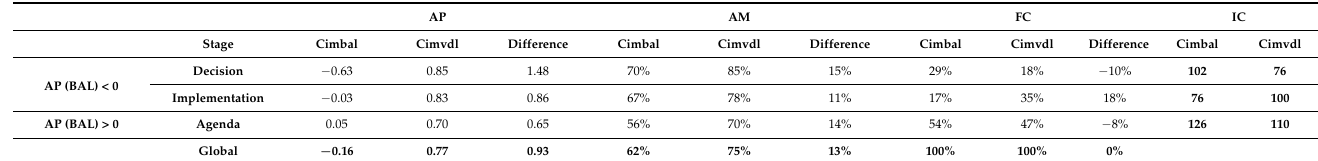
Table 5. Comparison of the CIMBAL and CIMVDL Cases According to the Four Indicators. Source: the